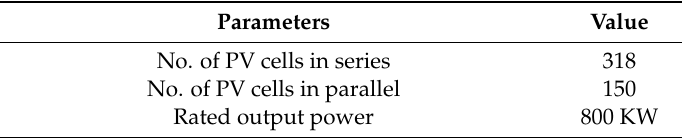
Table A2. PV and boost chopper